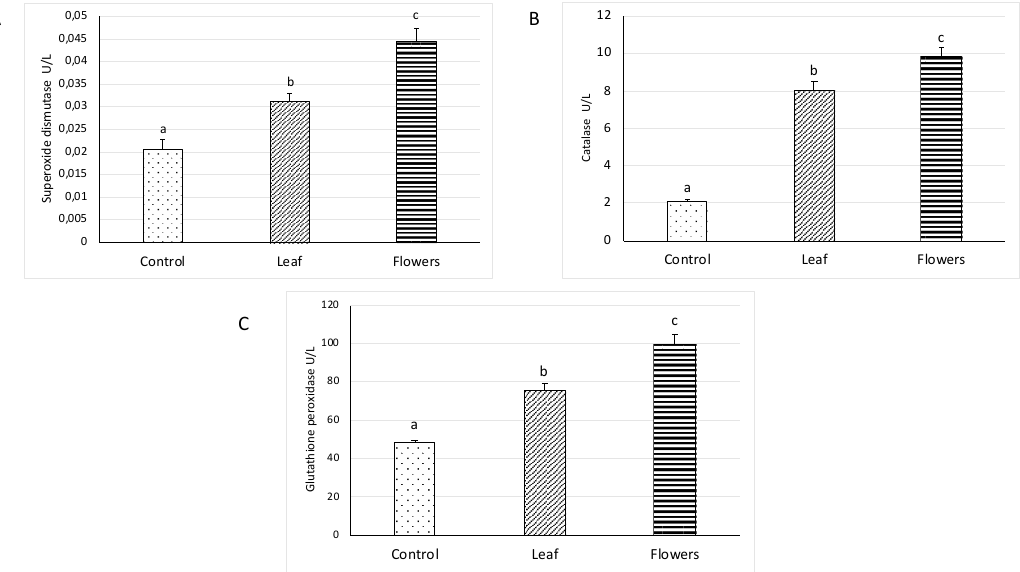
Figure 7. Effect of leaf and flowers essential oil extracts of A. secundiramea on activities of antioxidant enzymes in polymorphonuclear cells. ( A ) Superoxide dismutase; ( B ) catalase; ( C ) glutathione peroxidase. Data are presented as mean and standard error, and were analyzed with the paired t -test. * P < 0.001.